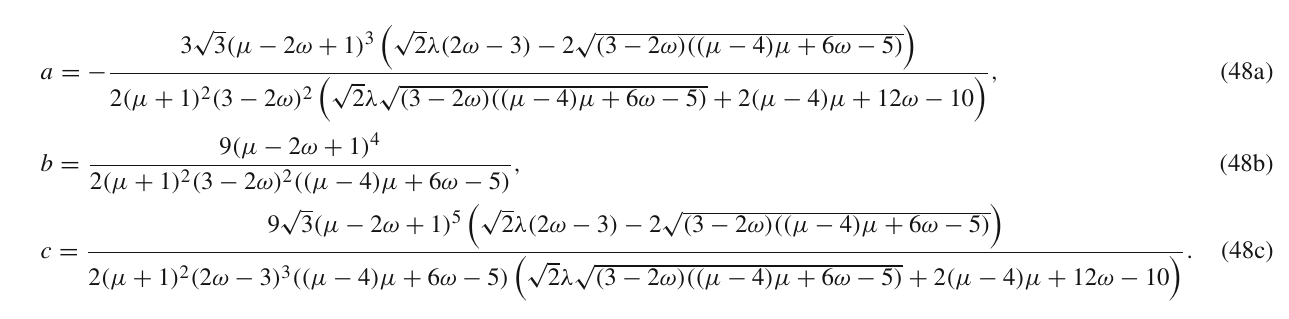
denote the implicit function x ( u ) 1 = 0, with x ( u ) and y ( u , v) defined by (44) for ω = 1. The dashed black lines in Fig. 5 represent the approximated center manifold of C − . In Fig. 6, we present the qualitative evolution